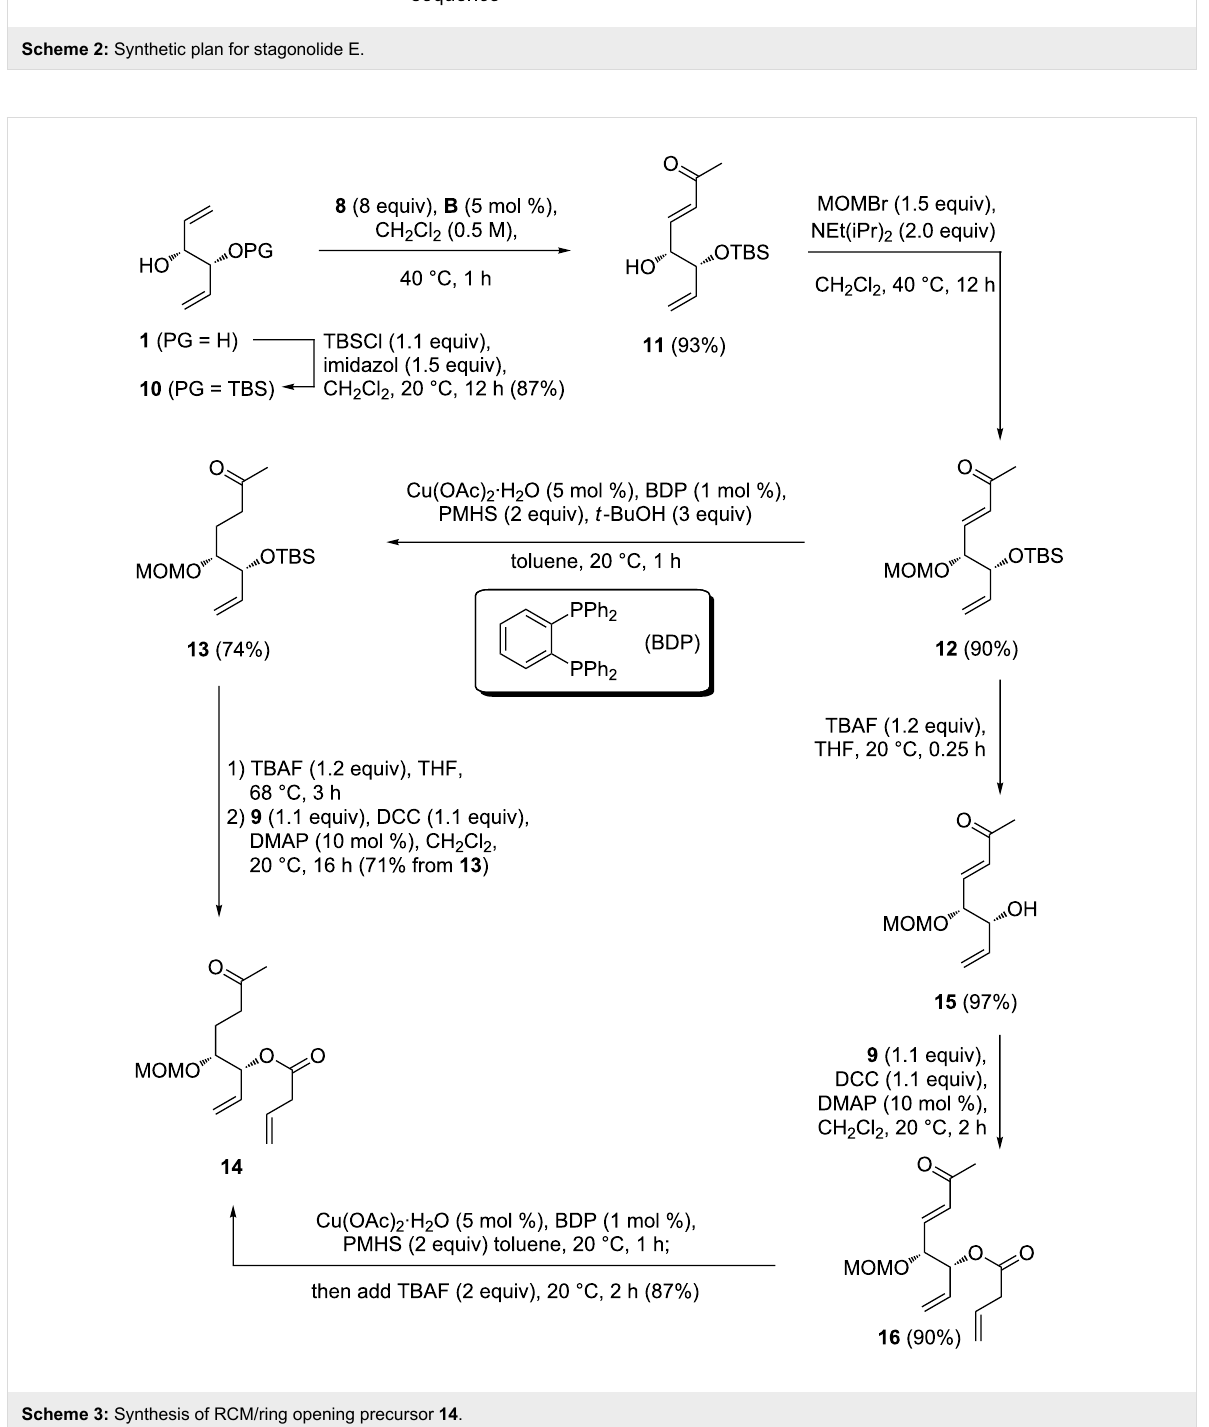
Scheme 3: Synthesis of RCM/ring opening precursor 14